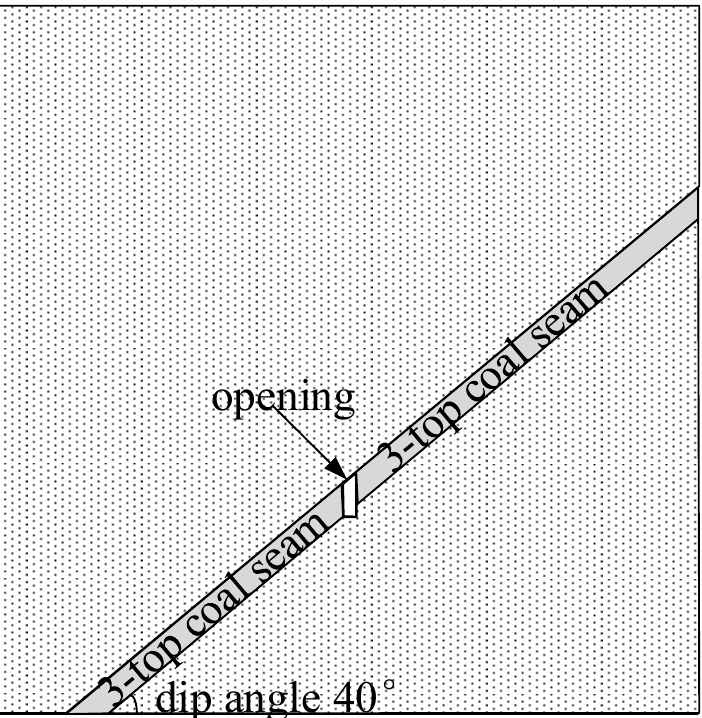
Figure 2. Schematic diagram of the opening with a right-angle trapezoidal shape in 3-top coal seam.